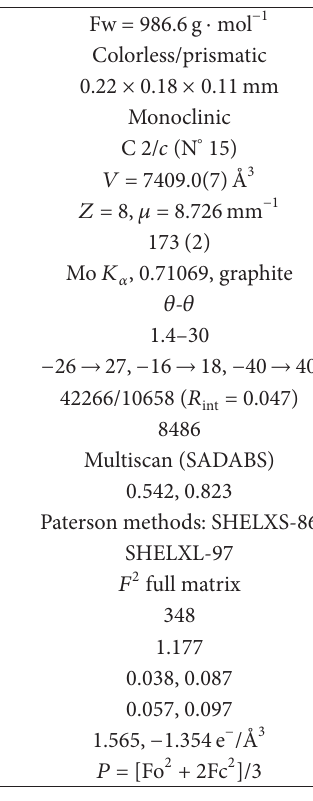
T 1: Summary of crystal data, X-ray diffraction intensity measurements, and re�nement parameters for [N(C